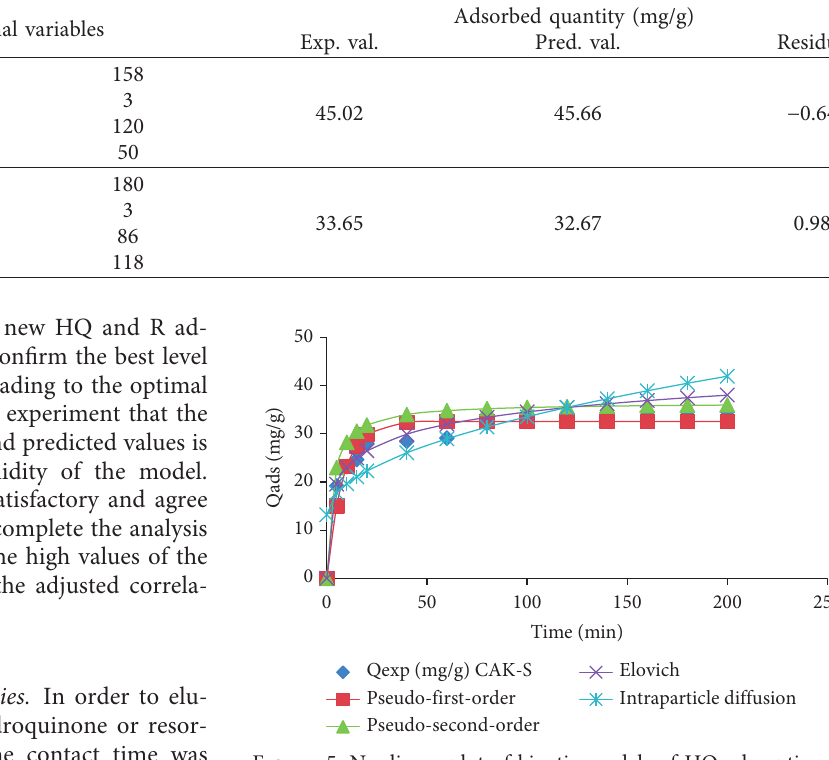
Figure 5: Nonlinear plot of kinetic models of HQ adsorption by CAK-S.